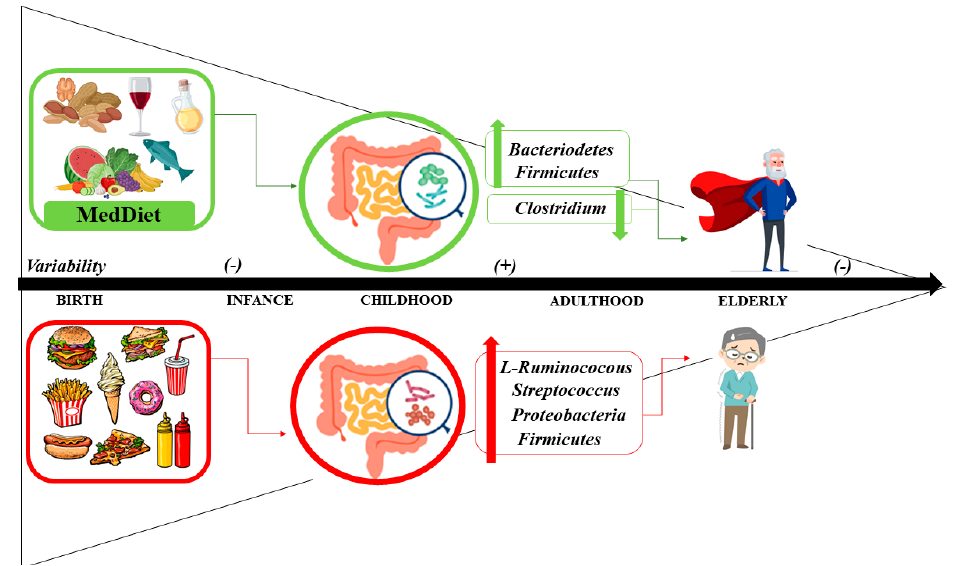
Figure 3. Influence of diet in gut microbiome related to aging.